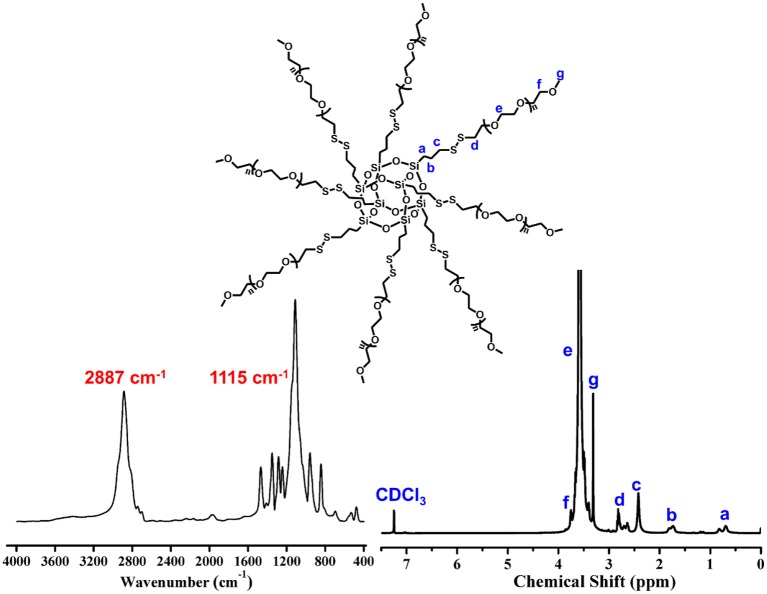
FT-IR and 1H NMR spectra of POSS-(SS-PEG)8.